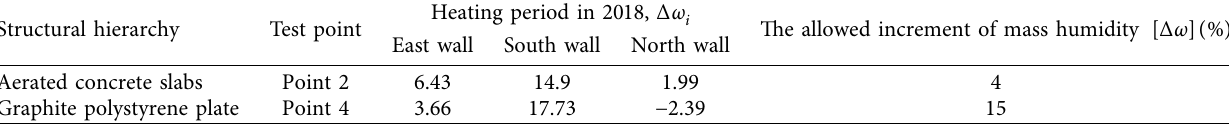
Table 5: Increment of mass humidity of insulation material inside the external wall after heating period. Structural hierarchy Test